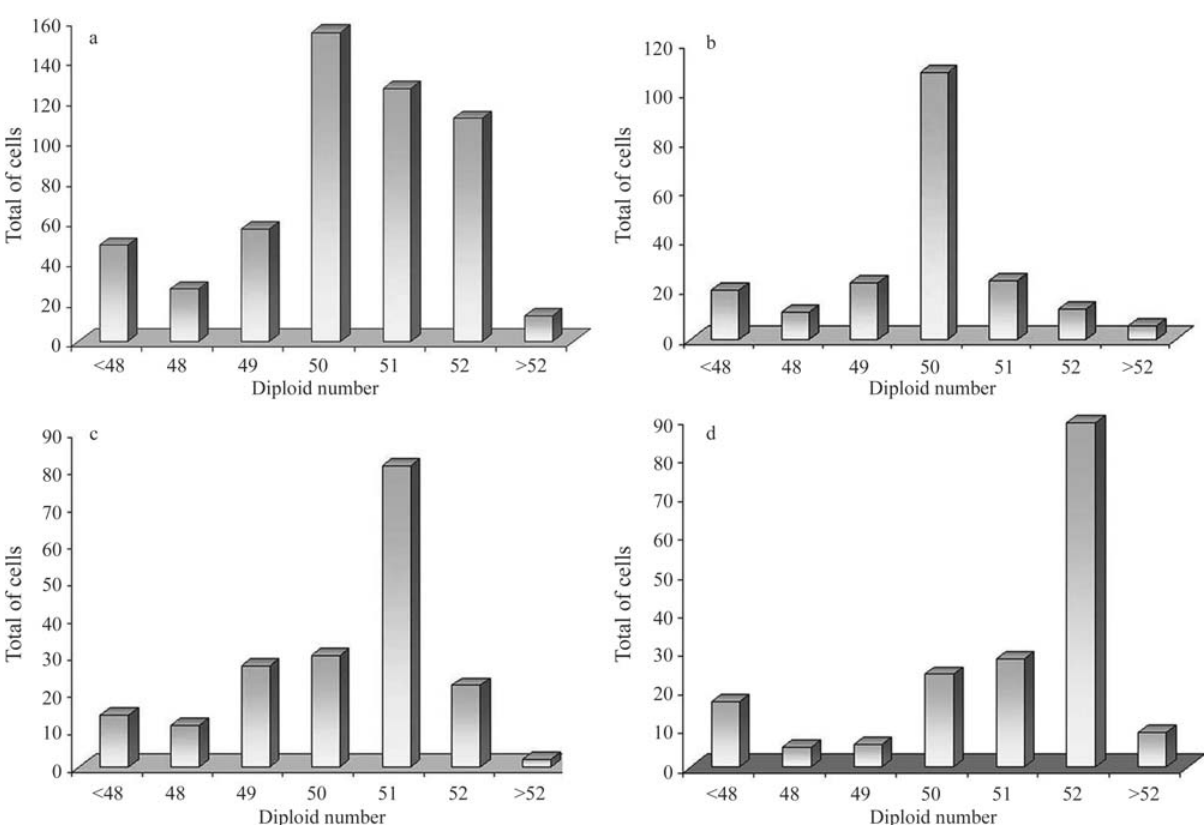
Figure 1 - Frequency of the diploid numbers in the Prata river Hoplerythrinus unitaeniatus population (a) total specimens analyzed; (b) specimens with a 2n = 50 modal diploid number (MDN); (c) specimens with a 2n = 51 MDN; (d) specimens with a 2n = 52